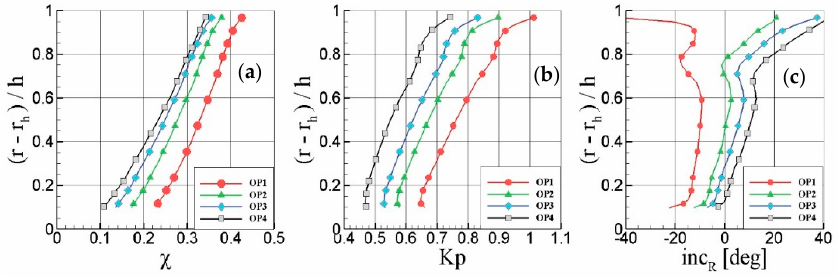
Figure 6. ( a ) Reaction coefficient, ( b ) Kp and ( c ) incidence span-wise profiles downstream of the stator.